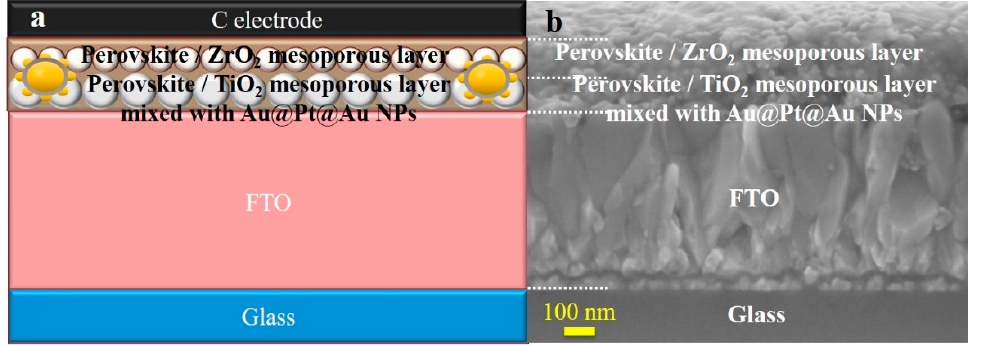
Figure 5. ( a ) The structure drawing of a whole mesoporous perovskite solar cells (PSC); ( b ) a cross image of a sample device.